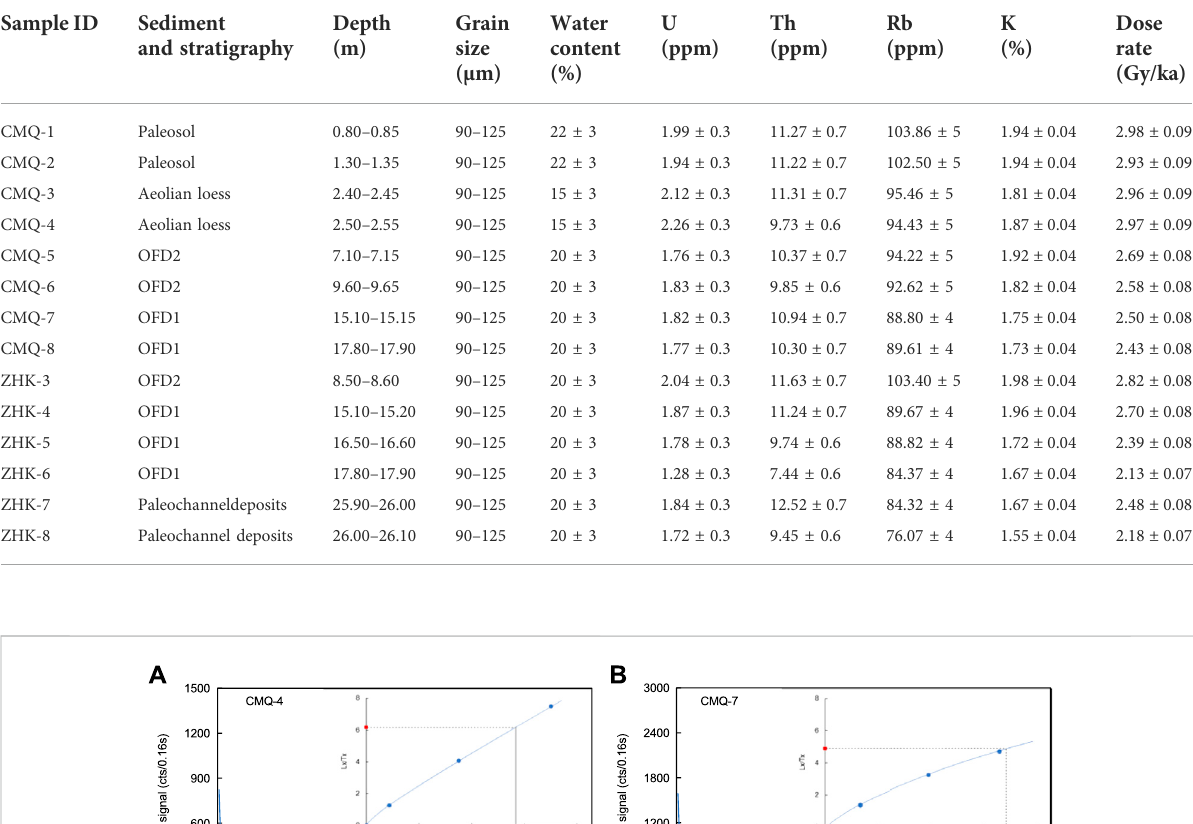
TABLE 4 Summary of the U, Th, K, Rb and dose rates for samples taken from overbank fl ood deposits (OFD), paleosol, aeolian loess, paleochannel deposits, glacial outwash/ fl ash fl ood deposits in the CMQ and ZHK pro fi les in the Yellow River source area on the NE Tibetan Plateau.